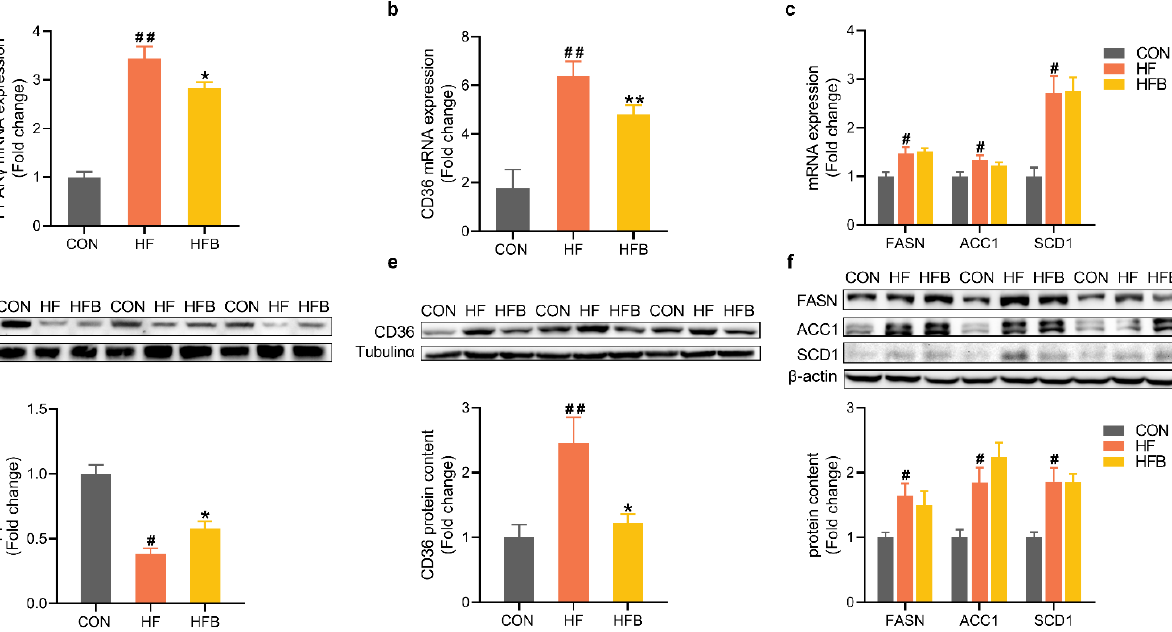
Figure 2. Hepatic genes expression involved in lipid metabolism. ( a ) Hepatic mRNA expression of PPAR γ ( n = 6). ( b ) Hepatic mRNA expression of CD36 ( n = 6). ( c ) Hepatic mRNA expression of ACC1, FASN and SCD1 ( n = 6). ( d ) Protein content of PPAR γ in the liver ( n = 6). ( e ) Protein content of CD36 in the liver ( n = 6). ( f ) Protein content of ACC1, FASN and SCD1 in the liver ( n = 6). Values are means ± SEM. # p < 0.05 and ## p < 0.01 compared with the CON group. * p < 0.05 and ** p < 0.01 compared with the HF group.